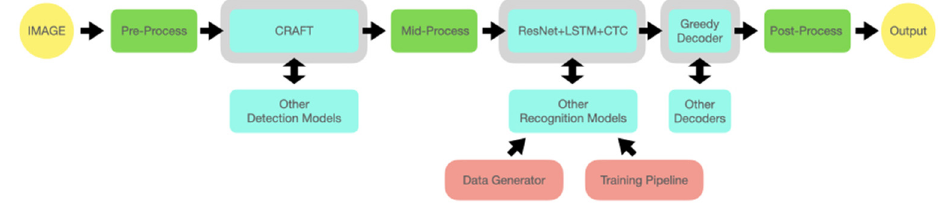
Figure 8. EasyOCR architecture.